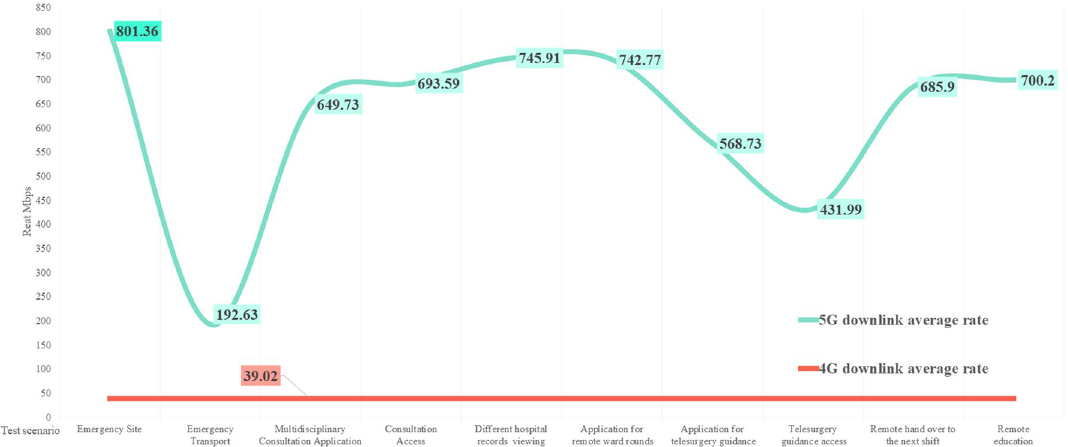
Figure 11. A comparison between the 5G downlink rate test value and the national 4G downlink rate average level in real